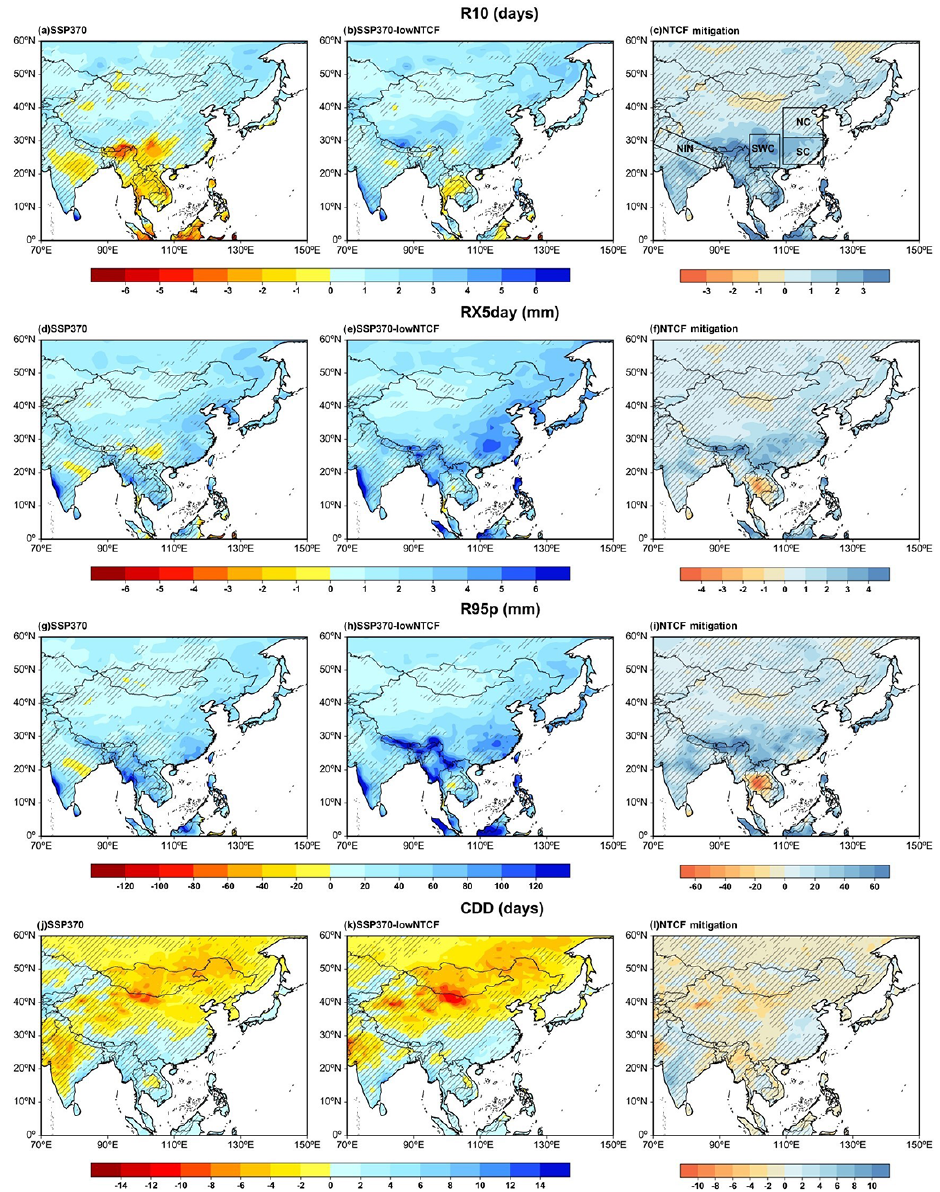
Figure 10. Spatial patterns of changes in heavy precipitation (R10; a–c ), maximum consecutive 5d precipitation (RX5day; d–f ), total wet-day precipitation (R95p; g–i ), and consecutive dry days (CDDs; j–l ) during 2031–2050 in Asia under the SSP3-7.0 (left column) and SSP3-7.0-lowNTCF (middle column) scenarios relative to 1995–2014. The right column represents changes caused by the non-methane SLCF mitigation. The areas with hatching indicate that at least one out of six models disagrees on the